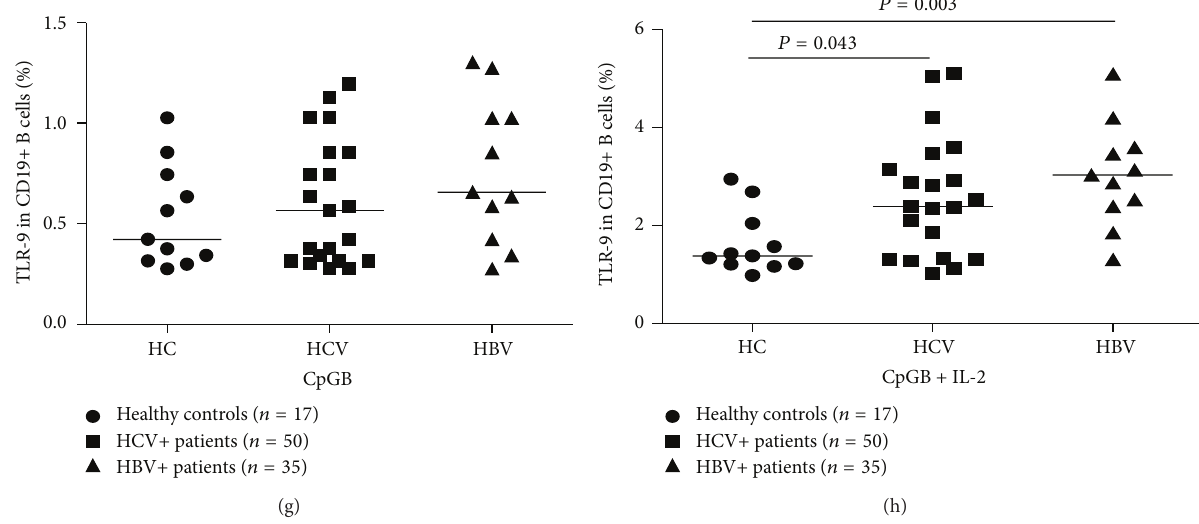
Figure 2: Patients with chronic HBV and HCV infections, and percentages of activated B cells and low percentages of exhausted B cells. B-lymphocytes from HCV patients (HCV, 𝑛 = 50 ), HBV patients (HBV, 𝑛 = 35 ), and healthy controls (HC, 𝑛 = 17 ) were analyzed by flow cytometry ex vivo for the expression of the activation marker (CD86), the exhaustion marker (CD95), and IgD. Data is shown as the frequency of the activation marker (CD86) on total (CD19+), plasma (CD19+CD38+), and nonplasma (CD19+CD38 − ) B cells, the expression of the exhaustion marker (CD95) on total (CD19+), memory (CD19+CD27+), and naive (CD19+CD27 − ) B cells, and the frequency of IgD and TLR-9 on total (CD19+) B cells stimulated with CpGB ± IL-2. Data are expressed as mean % of individual samples from at least two separate experiments. Data were analyzed by the Wilcoxon rank-sum test. The horizontal lines show the median